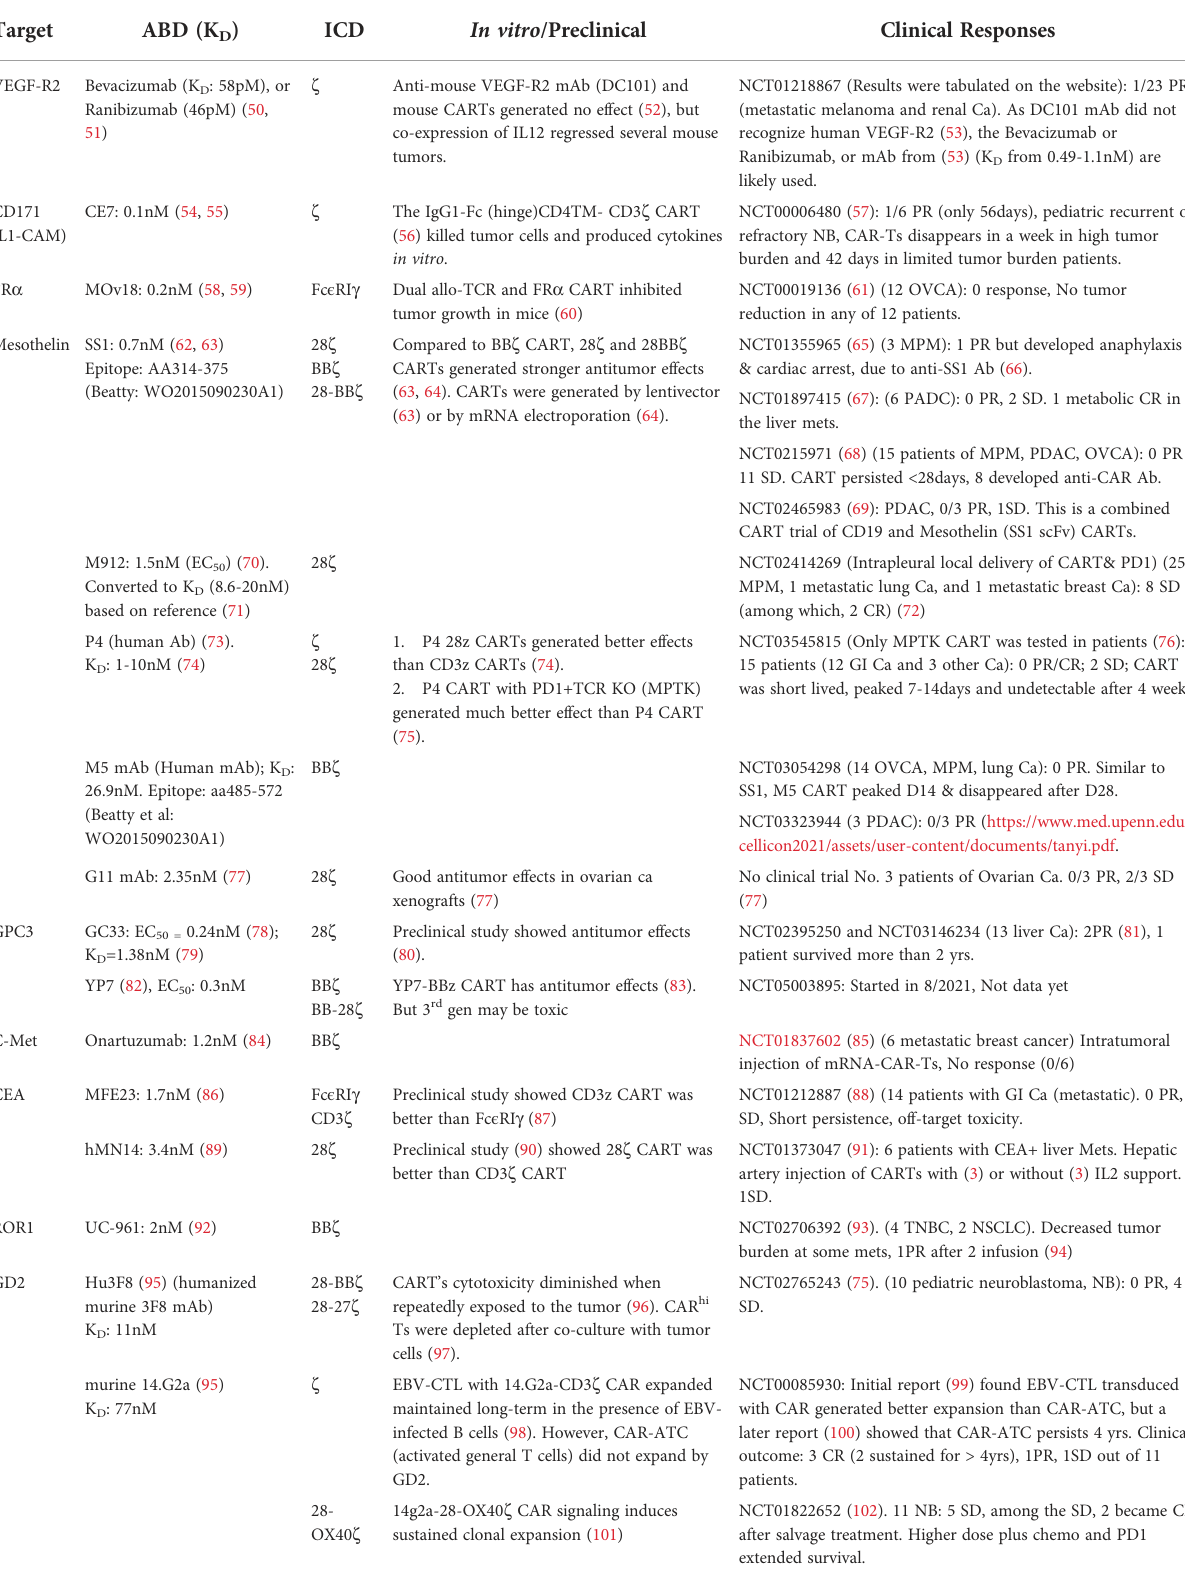
TABLE 1 Summary of solid tumor CAR-T clinical trials: Af fi nity of antigen binding domains vs. clinical ef fi